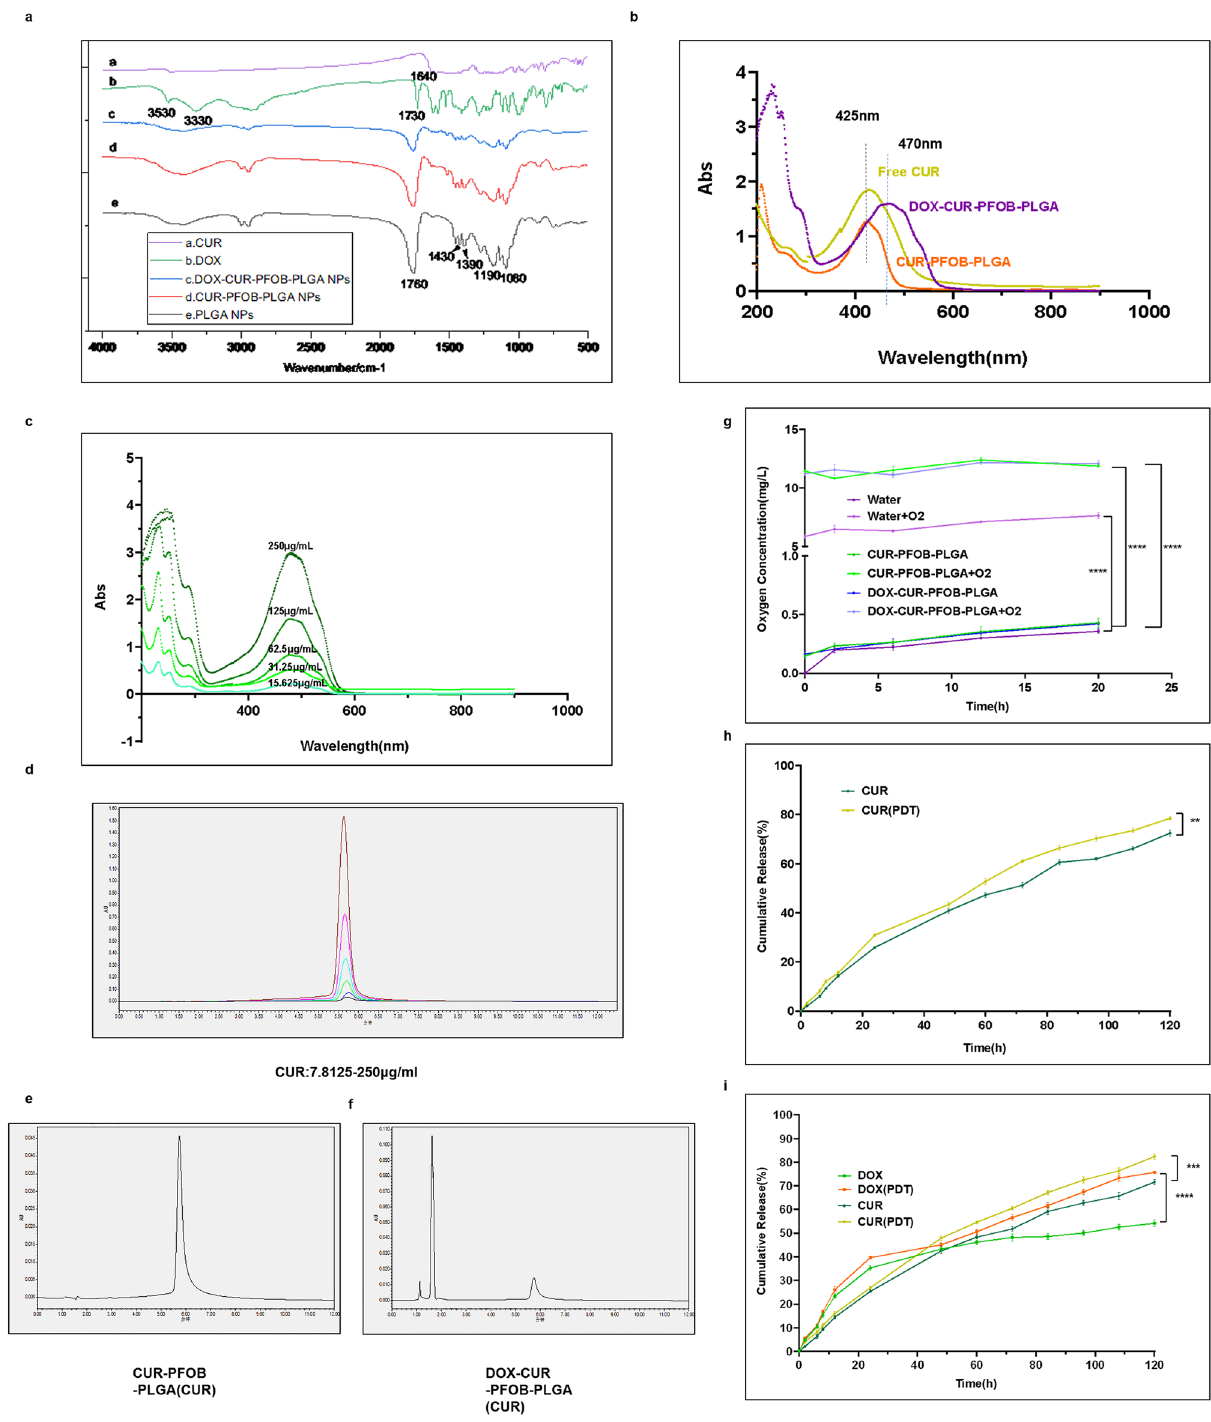
Figure 3. Characterization of nanoparticles. ( a ) Chemical structure analysis in FTIR ( a CUR, b DOX, c DOX–CUR–PFOB–PLGA NPs, d CUR–PFOB–PLGA NPs, e PLGA NPs); ( b ) Absorbance of CUR, CUR–PFOB–PLGA NPs and DOX–CUR–PFOB–PLGA NPs by UV spectrophotometer (Horizontal coordinate: scanning wavelength, vertical coordinate: absorbance); ( c ) Absorbance of different concentrations of DOX under UV spectrophotometer (DOX: 15.625–250 μg/mL, horizontal coordinate is detection wavelength and vertical coordinate is absorbance); ( d ) Absorbance of different concentrations of CUR under HPLC (CUR: 7.8125–250 μg/mL, horizontal coordinate is absorption peak time, vertical coordinate is absorbance and the peak time of CUR is between 5 and 6 min); ( e ) Absorbance of CUR in CUR–PFOB–PLGA NPs at 5–6 min in HPLC; ( f ) Absorbance of CUR in DOX–CUR–PFOB–PLGA NPs at 5–6 min in HPLC; ( g ) Oxygen concentrations in NP solution with or without oxygen infusion at different time points were measured by portable dissolved oxygen meter (nanoparticles need to be oxygenated for 10 min); ( h ) Time dependent changes of the amount of CUR from CUR–PFOB–PLGA NPs by laser irradiation or not was measured by HPLC; ( i ) Cumulative release rates of DOX with or without laser irradiation from DOX–CUR–PFOB–PLGA NPs were measured by UV spectrophotometer and CUR were measured by HPLC. Statistics were analyzed by GraphPad Prism 8.0 (https:// www. graph pad. com/ updat es); ** P < 0.01; *** P < 0.001; **** P <